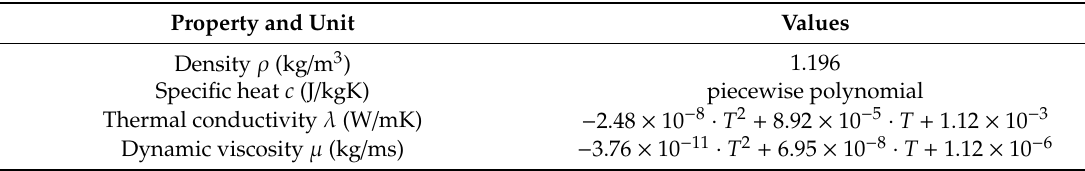
Table 1. The properties of